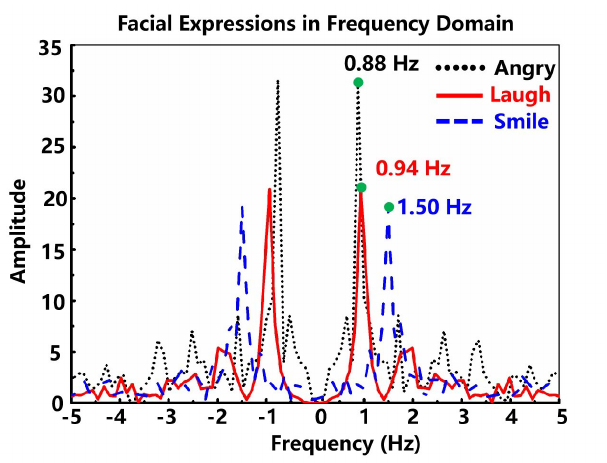
Figure 5. The signals of the facial expressions transformed into the frequency domain.